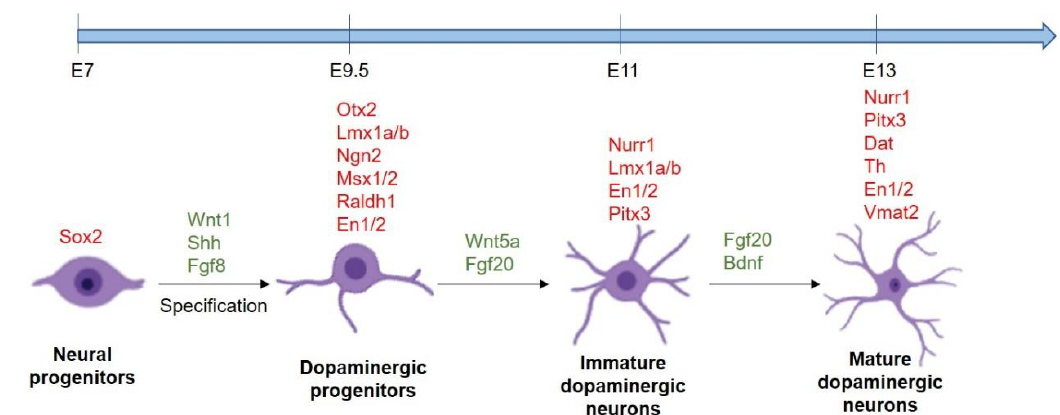
Figure 3. The timing of expression of transcription factors during the development of midbrain DA neurons. Transcription factors are indicated in red, whereas the main signaling pathways activated are indicated in green.